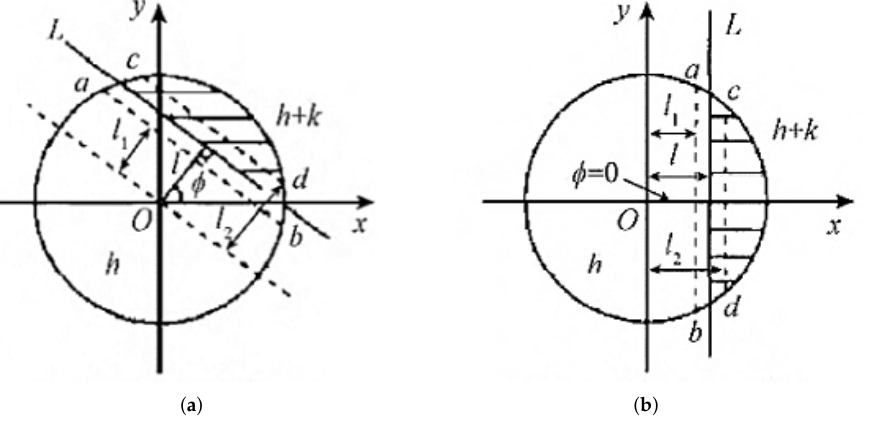
Figure 6. Subpixel edge detection model. ( a ) Original edge image, ( b ) The rotated edge image. In Figure 6, line L , represents the ideal edge, and the unit circle is divided into two gray regions by line L . h is the background gray level, k is the step height (gray difference), and l is the vertical distance of the center of the circle. The two dashed lines ab and cd correspond to the image edge under the conditions of Franklin moments of different orders. The specific values are given by Equations (16) and (17). ϕ is the included angle between the vertical line segment from the center of the circle to the edge and the X -axis. Figure 6b is obtained by rotating the angle ϕ clockwise from Figure 6a, where lines ab and cd are parallel to the Y